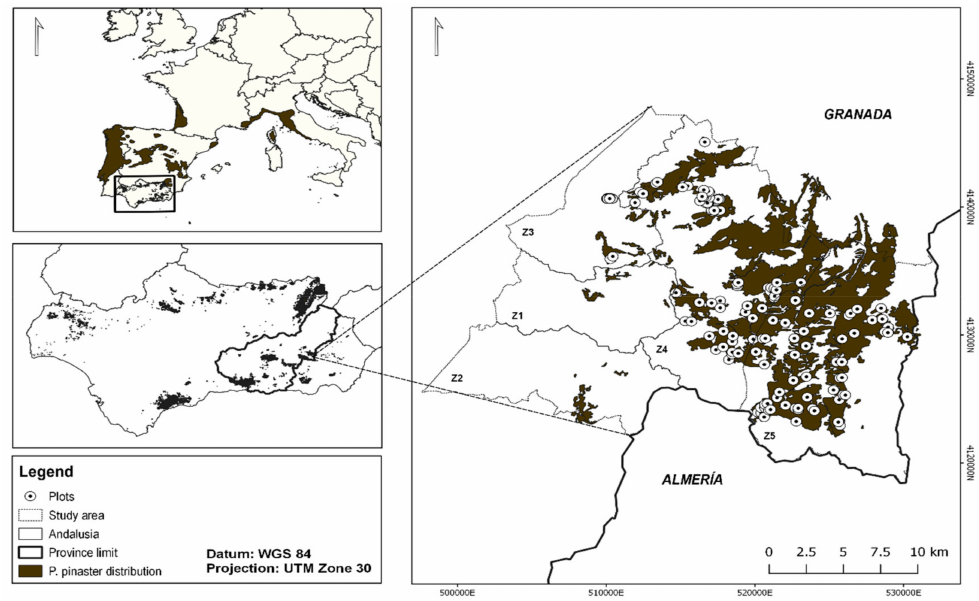
Figure 1. Location of Pinus pinaster forests in Sierra de Baza (37 ◦ 13 (cid:48) N, 2 ◦ 32 (cid:48) W) and sampled plots (N = 64; circles). A map showing the distribution of Maritime pine in the western Mediterranean Basin (upper inset left, brown area) with a square (black box) indicating the study area in SE Spain (Andalusia-Granada, lower inset